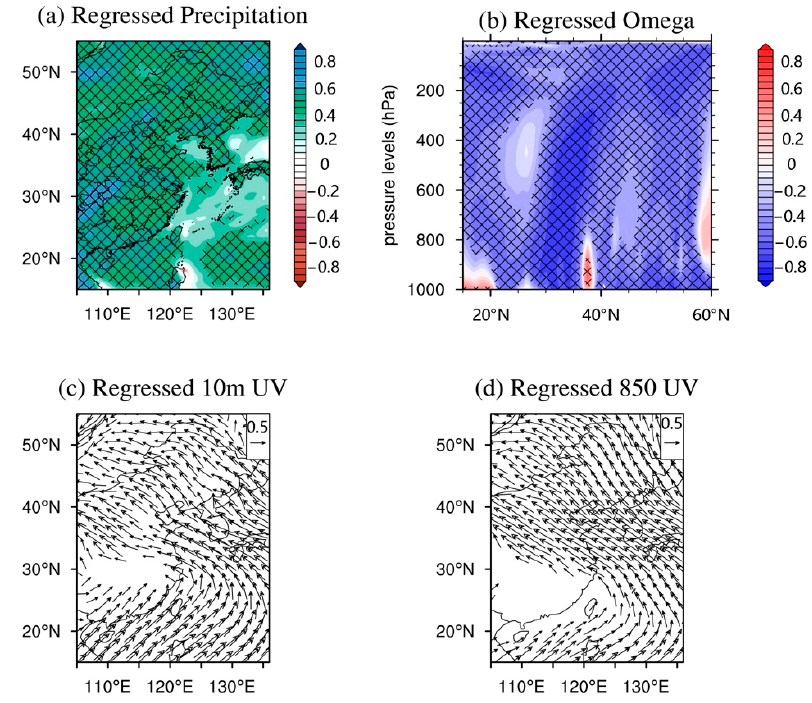
Figure 7. Regressed precipitation ( a ), vertical velocity ( b ), surface wind at 10 m ( c ), and 850 hPa wind ( d ) on the AQI PC1. The black crosses in panels ( a , b ) represent regions with regression significant at 99% confidence level. Shown in panel ( c , d ) are only the wind vectors that are significant above a 99% confidence level.